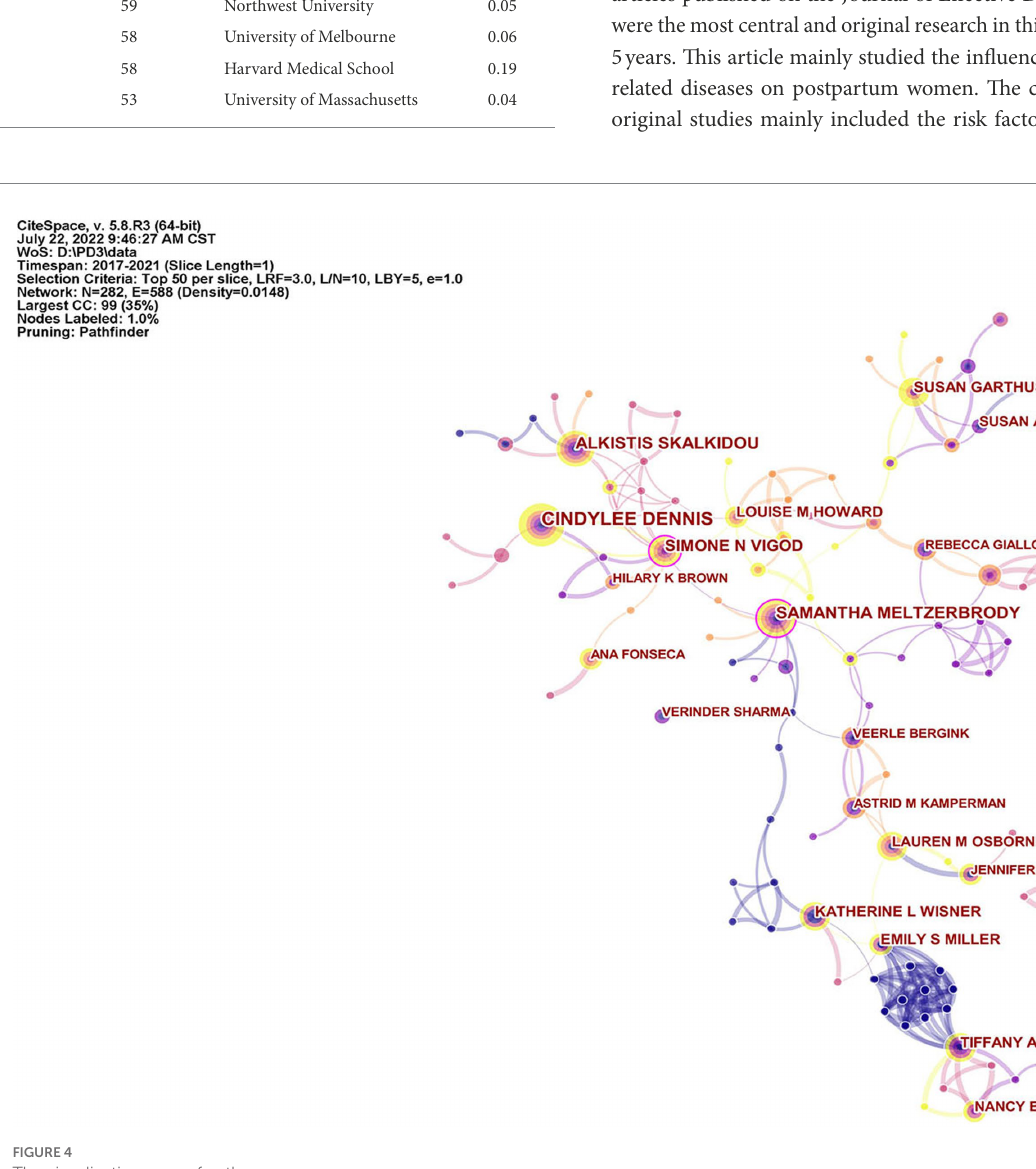
FIGURE 4 The visualization map of